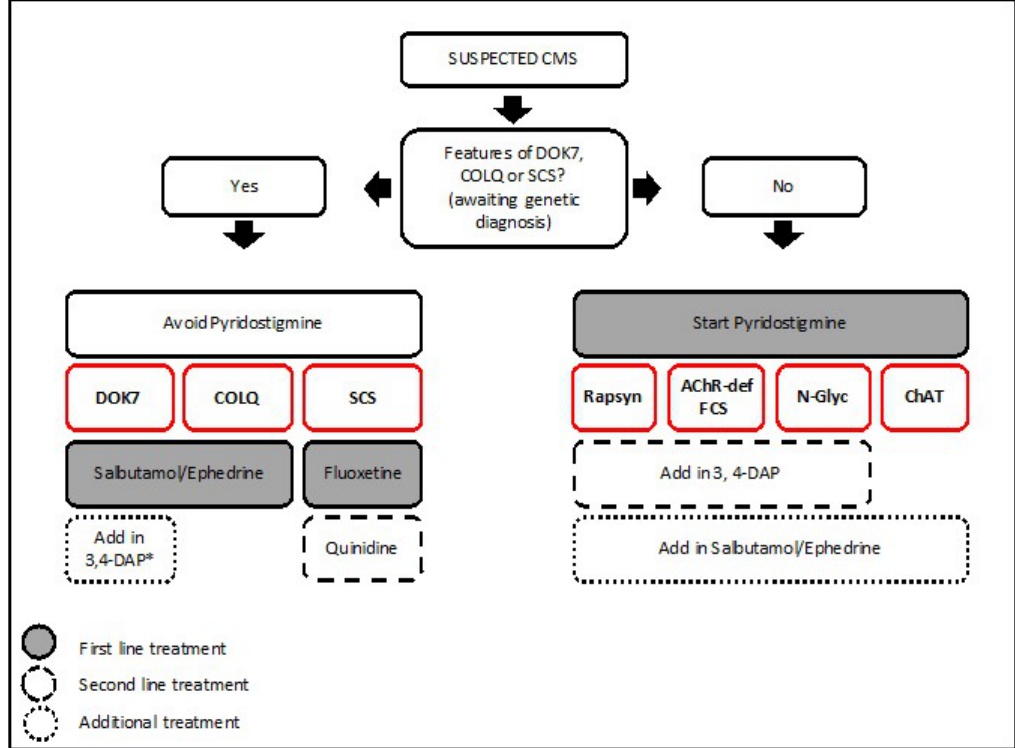
Figure 8. Treatment strategy at the Oxford CMS Service for most common CMS subtypes. Whenever features of DOK7 and other members of the AGRN–MUSK pathway, COLQ, or SCS are present, first-line treatment with pyridostigmine should be avoided until confirmation of genetic diagnosis. 3,4-DAP can be added in with caution in certain CMS subtypes (* use with caution) [137]. Combined therapy with β2 -adrenergic agonists may be tried on AChR deficiency, CMS due to glycosylation defects, FCS, and rapsyn CMS. In cases of SCS, quinidine may be used as an alternative to fluoxetine.